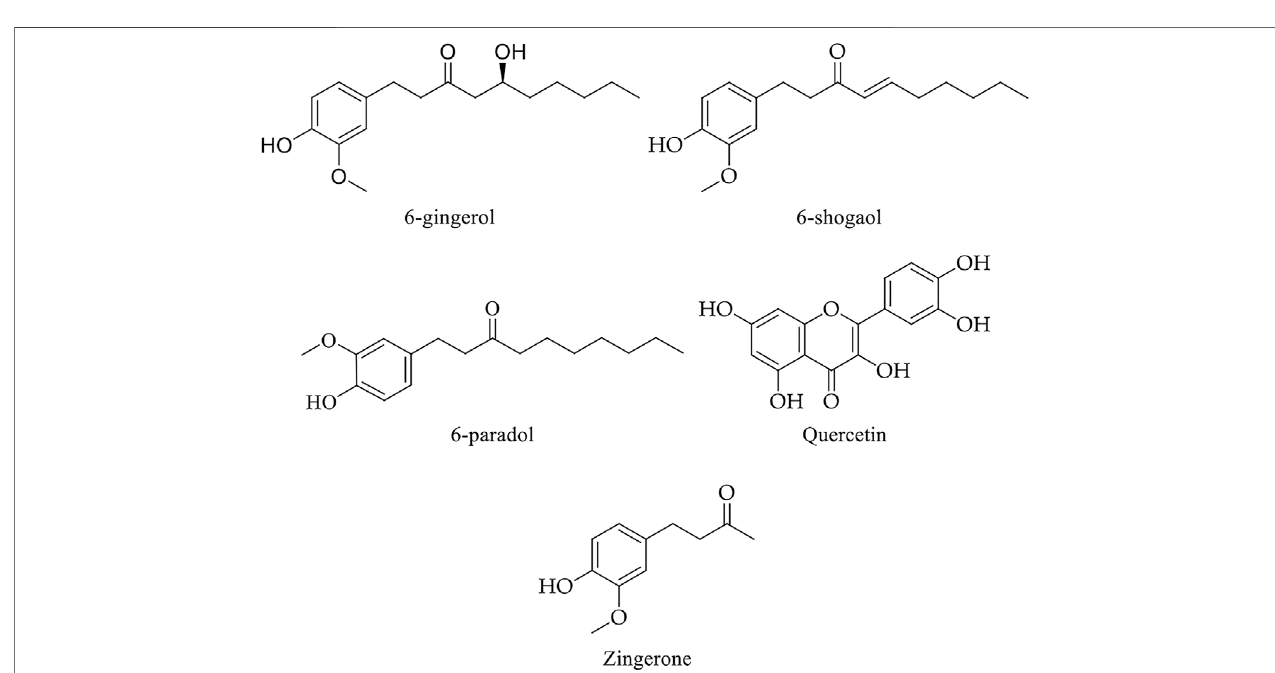
FIGURE 6 | Chemical structure of main non-volatile bioactive compounds of ginger.